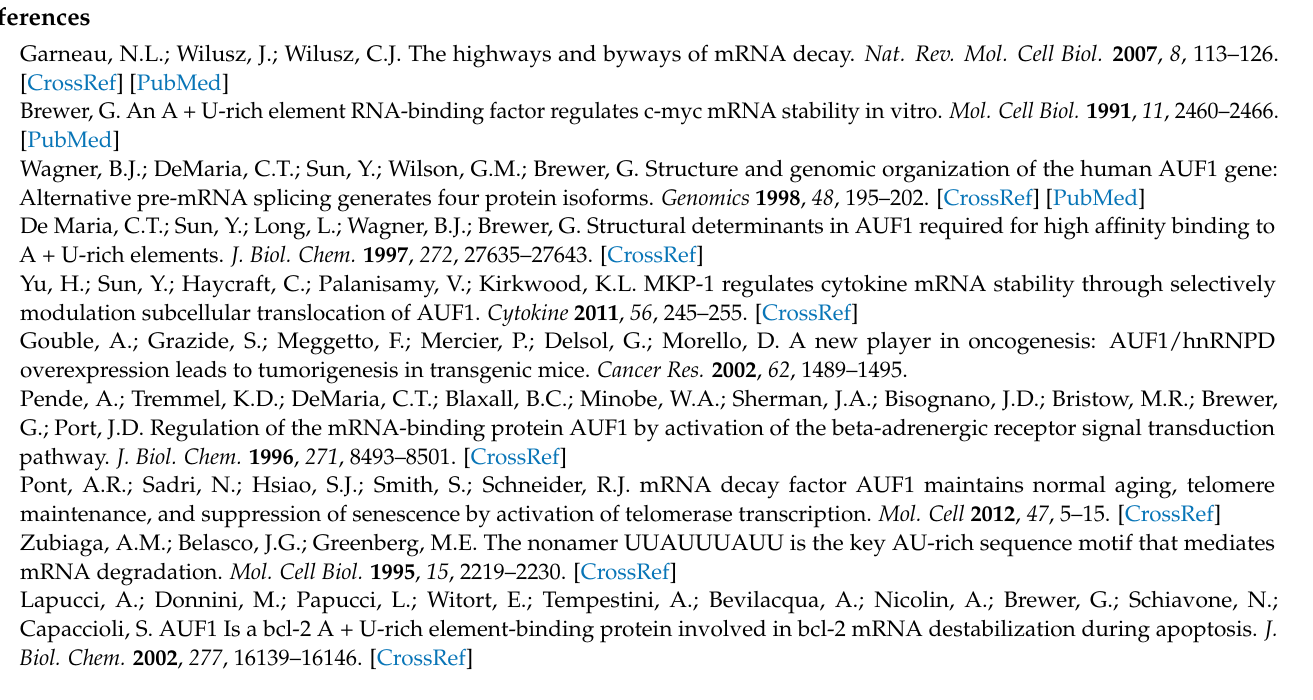
AUF1 target genes; Figure S2: Gene ontology (GO) of JNJ-7706621 regulated genes; Figure S3: The REMSA result of the FAM-labelled RNA (250 nM) incubated with AUF1 at increasing concentrations; Figure S4: General synthesis of 1,2,4-triazole-3,5-diamine derivatives; Table S1: The RU values of 186 selected compounds; Table S2: Differentially expressed genes with the most significant difference in RIP-seq; Table S3: Differentially expressed genes (up-regulated) with the most significant difference in RNA-seq; Table S4: Differentially expressed genes (up-regulated) with the most significant difference combined the data in RIP-seq and RNA-seq; Table S5: Sequence of wild-type and deletion 3 (cid:48) UTR of